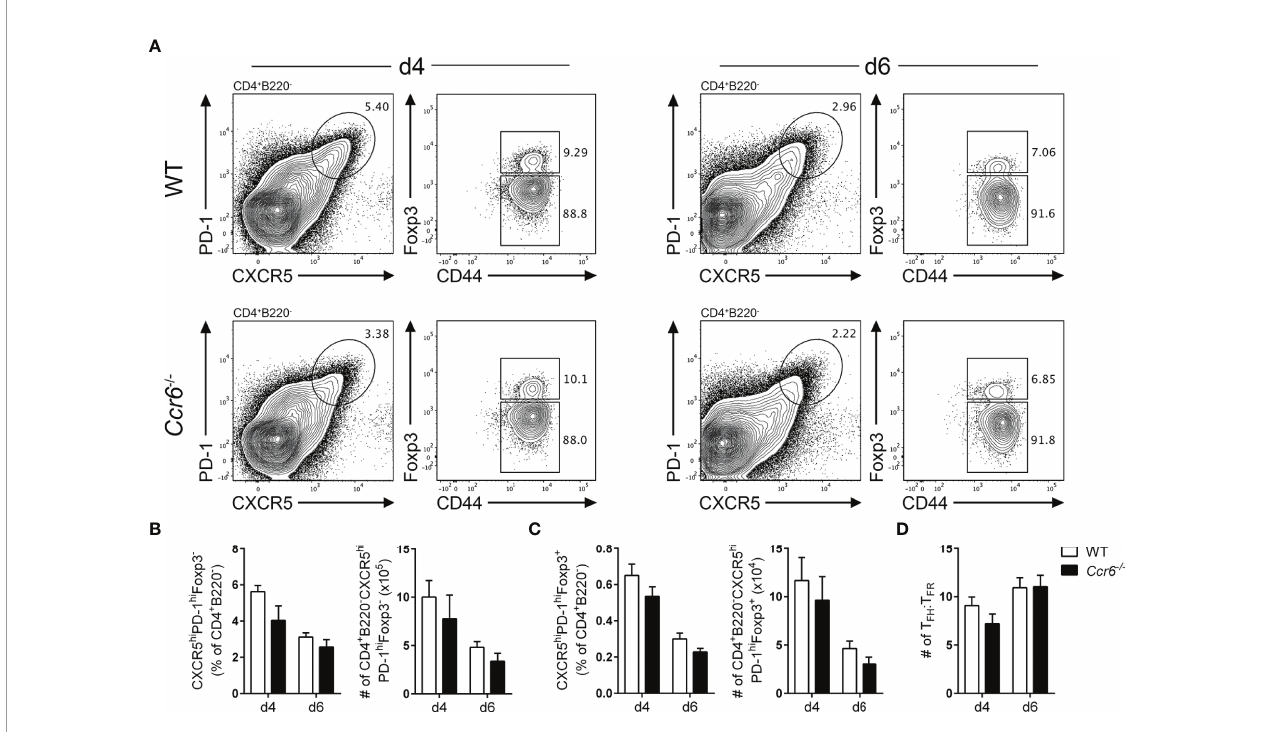
FIGURE 4 | CCR6-de fi cient mice mount normal T FH and T FR cell responses. (A) Representative gating strategy of T FH cells (CD4 + B220 - CXCR5 hi PD- 1 hi CD44 hi Foxp3 - ) and T FR cells (CD4 + B220 - CXCR5 hi PD-1 hi CD44 hi Foxp3 + ) in WT and Ccr6 -/- mice four- and six-days post SRBC immunization. Frequency and number of (B) T FH and (C) T FR cells from (A) . (D) Ratio of T FH : T FR cells four- and six-days post SRBC immunization in WT and Ccr6 -/- mice. (A – D) Data representative of 3 independent experiments, n=6-7 mice/time point ± SEM, two-tailed unpaired Student ’ s t test between strains at each time